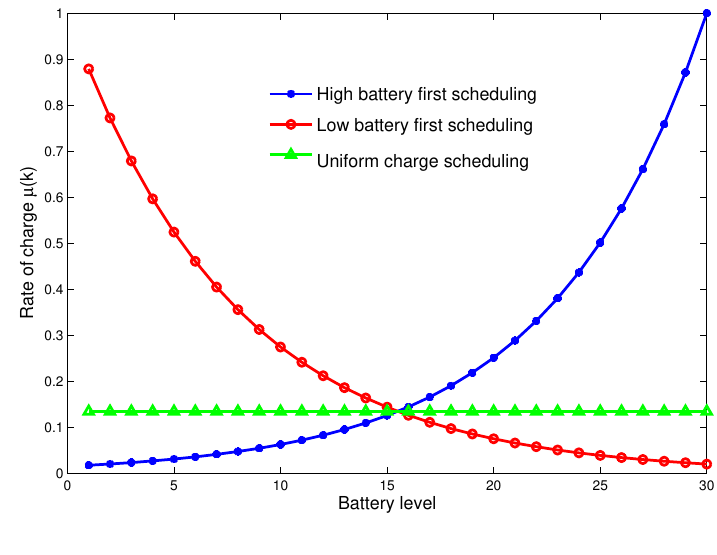
Figure 5. The rate of charge µ ( k )